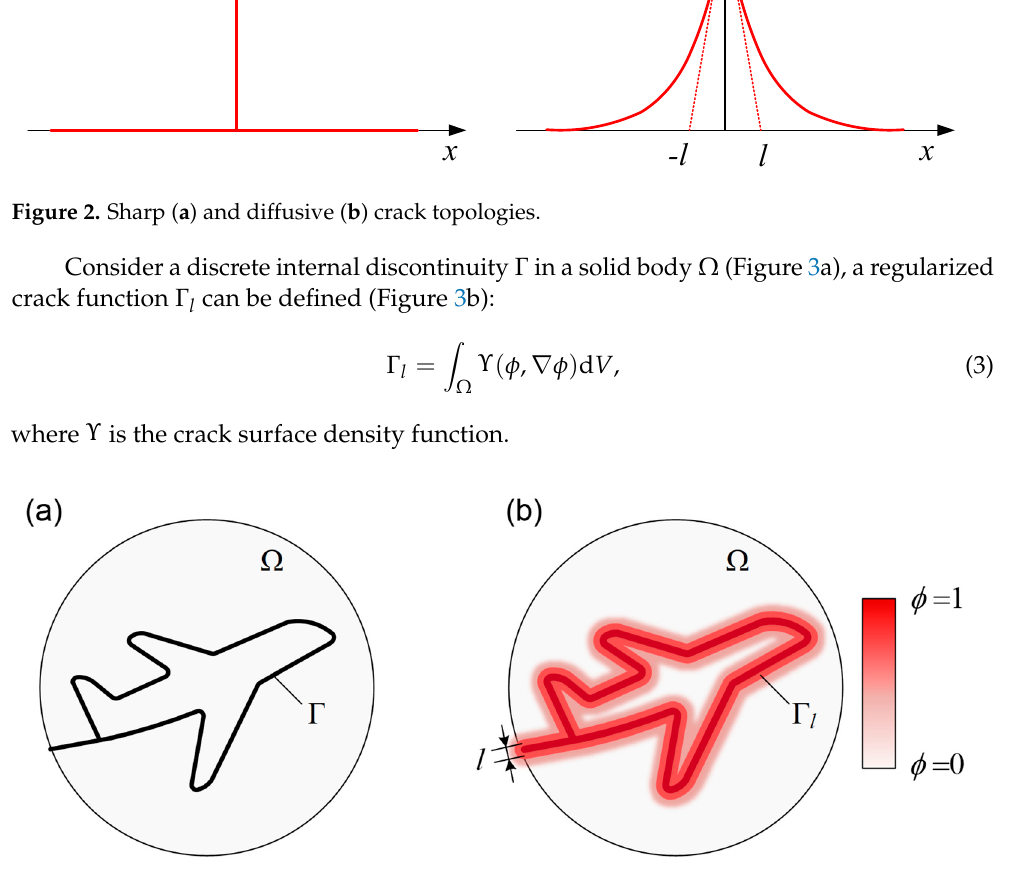
Figure 2. Sharp ( a ) and di ff usive ( b ) crack topologies. Figure 3. Schematic representation of a solid body. ( a ) Internal discontinuity boundaries, and ( b ) a phase fi eld approximation of the discrete discontinuities.